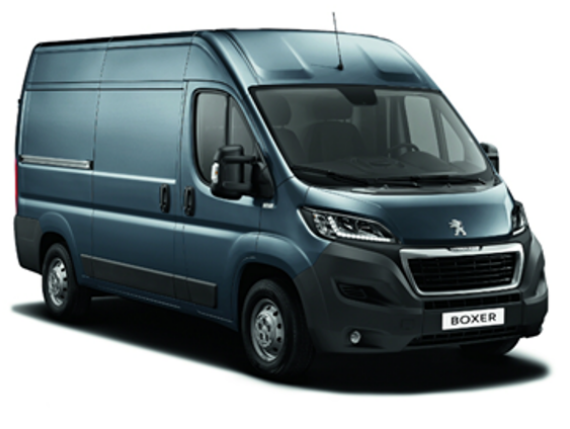
Figure 2: Variant solution D5 – Peugeot Boxer